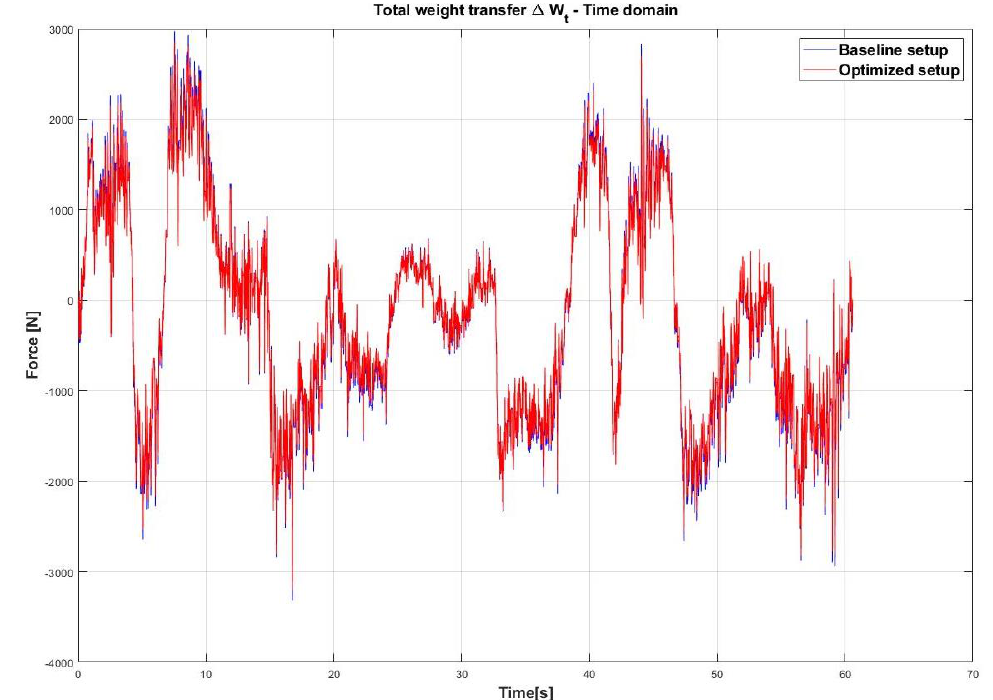
Figure 26. Comparison between the baseline provided setup and improved setup for the total weight transfer of the car in the time